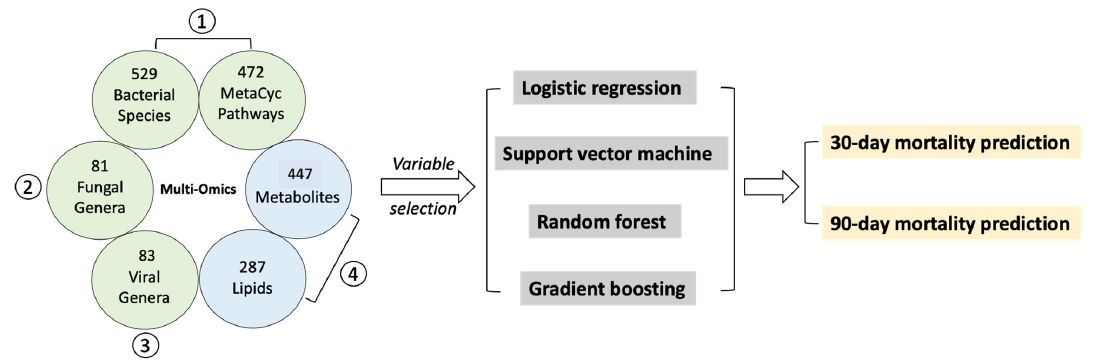
Figure 2. Multi-omics datasets used for mortality prediction in patients with alcoholic hepatitis. A total of (1) 529 fecal bacterial species and 472 MetaCyc pathways, (2) 81 fecal fungal genera, (3) 83 fecal viral genera, (4) 447 serum metabolites and 287 serum lipids were included.